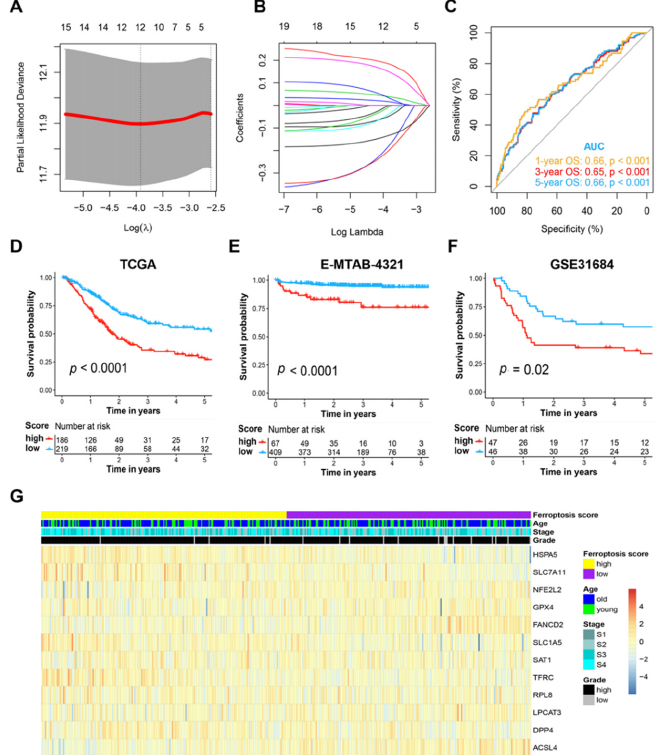
Figure 1. Prognosis model based on ferroptosis-related genes for BCa. ( A , B ) The 10-fold cross-validated error and coefficients at varying levels of penalization plotted against the log (lambda) sequence for the least absolute shrinkage and selection operator analysis, respectively. ( C ) ROC curve of 1-, 3-, and 5-year OS prediction based on the ferroptosis score. ( D ) Kaplan - Meier survival analysis of OS stratified by ferroptosis score for BCa patients in the TCGA cohort. ( E ) Kaplan - Meier survival analysis of DFS stratified by ferroptosis score in the validation E-MTAB-4321 cohort. ( F ) Kaplan - Meier survival analysis of OS stratified by ferroptosis score in another validation of the GSE31684 cohort. ( G ) Heatmap illustrating the expression of the selected genes and the distribution of clinicopathologic factors in the TCGA cohort. BCa, bladder cancer; TCGA, The Cancer Genome Atlas; ROC, receiver operating characteristic; AUC, area under the curve; OS, overall survival; DFS, disease-free survival; S1, Stage I; S2, Stage II; S3, Stage III; S4, Stage IV.